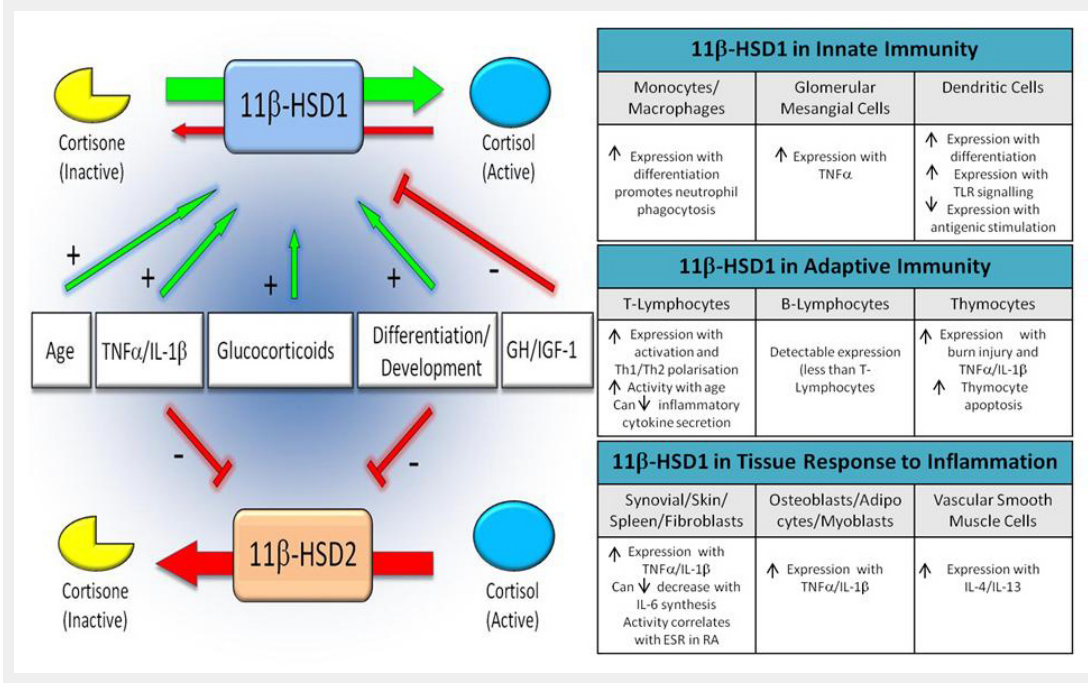
Figure 2 Overview of the cortisol activating enzyme 11β-HSD1, and the cortisol inactivating enzyme 11β-HSD2 and their regulation within different leukocyte subsets.